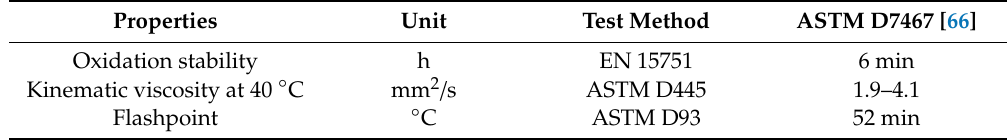
Table 5. ASTM D7467 requirements for diesel blends B6-B20.